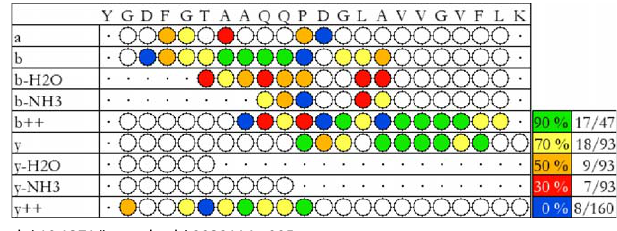
Figure 5. Peptide